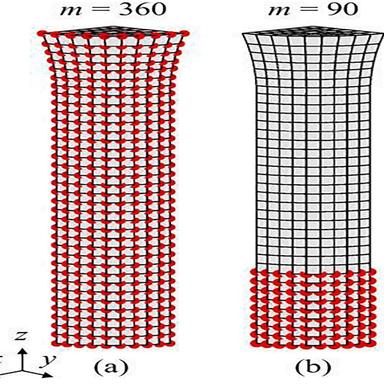
Red circles indicate the synthetic measurement points at which the synthetic observation data of the displacement and strain are extracted for (a) the reference case and Cases B and C and (b) Case A. m represents the number of synthetic measurement points.